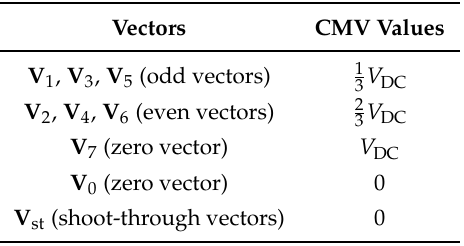
Table 1. CMVs with relevant vectors in the